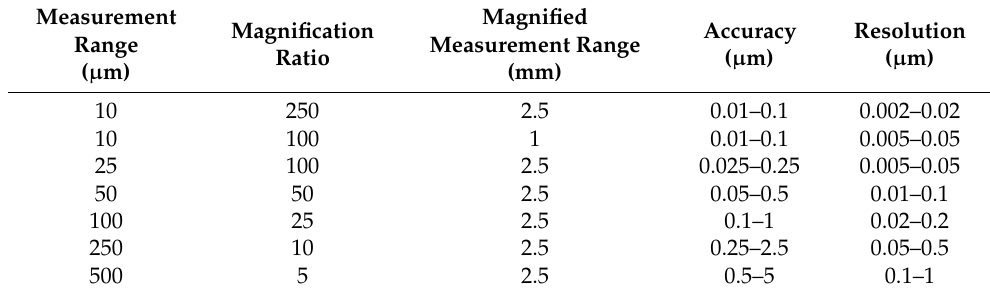
Table 2. Relation between mechanical magnification ratio and measurement range, with corre- sponding accuracy and resolution, based on a Hall sensor of a measurement resolution of 5 μ m and an accuracy of 0.1–1% of the full measurement range.